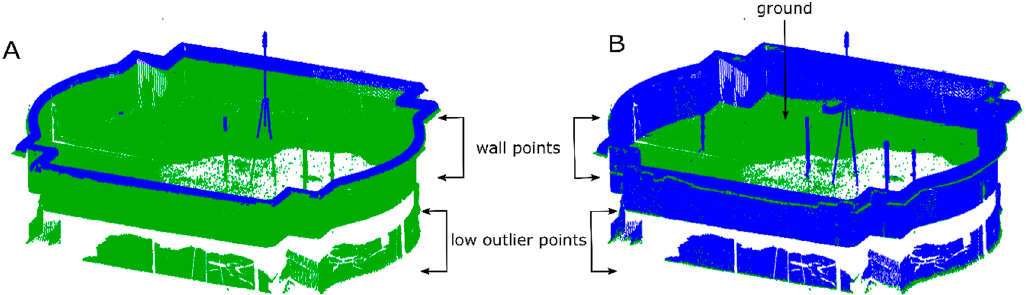
Figure 7. Ground points classified using the HWRI ( A ) and MSBF ( B ) classifiers for the high corn site demonstrating the misclassification of OT points when there were no ground points beneath (as seen from above at an oblique angle).